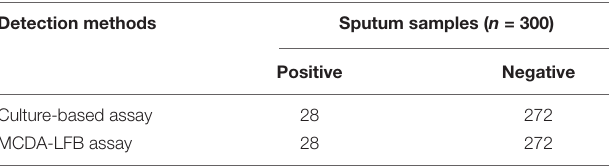
TABLE 3 | Comparison of methods for detection of C. tropicalis in sputum samples. Detection